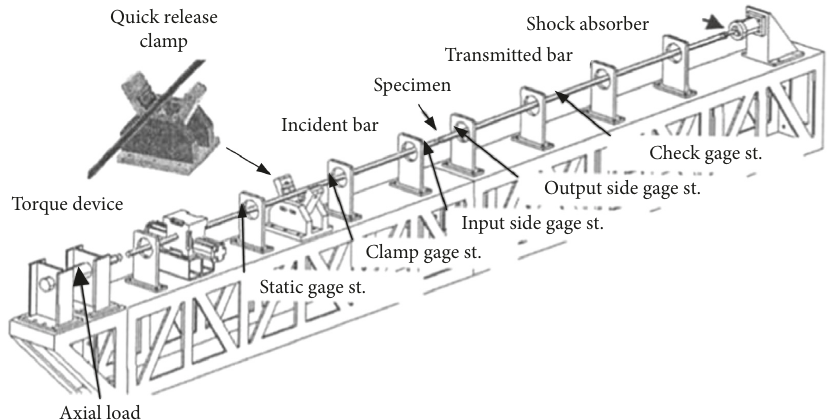
Figure 18: TSHB for dynamic compression-torsion modified by Espinosa et al. [70].